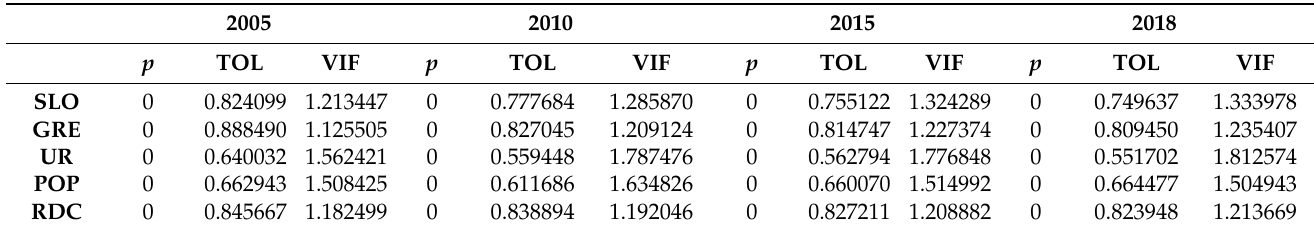
Table 3. Multicollinearity test results in 2005, 2010, 2015, and 2018. SLO, slope; RDC, river distance accessibility; GRE, per capita green area; UR, the proportion of urban and rural human settlements; POP, population.